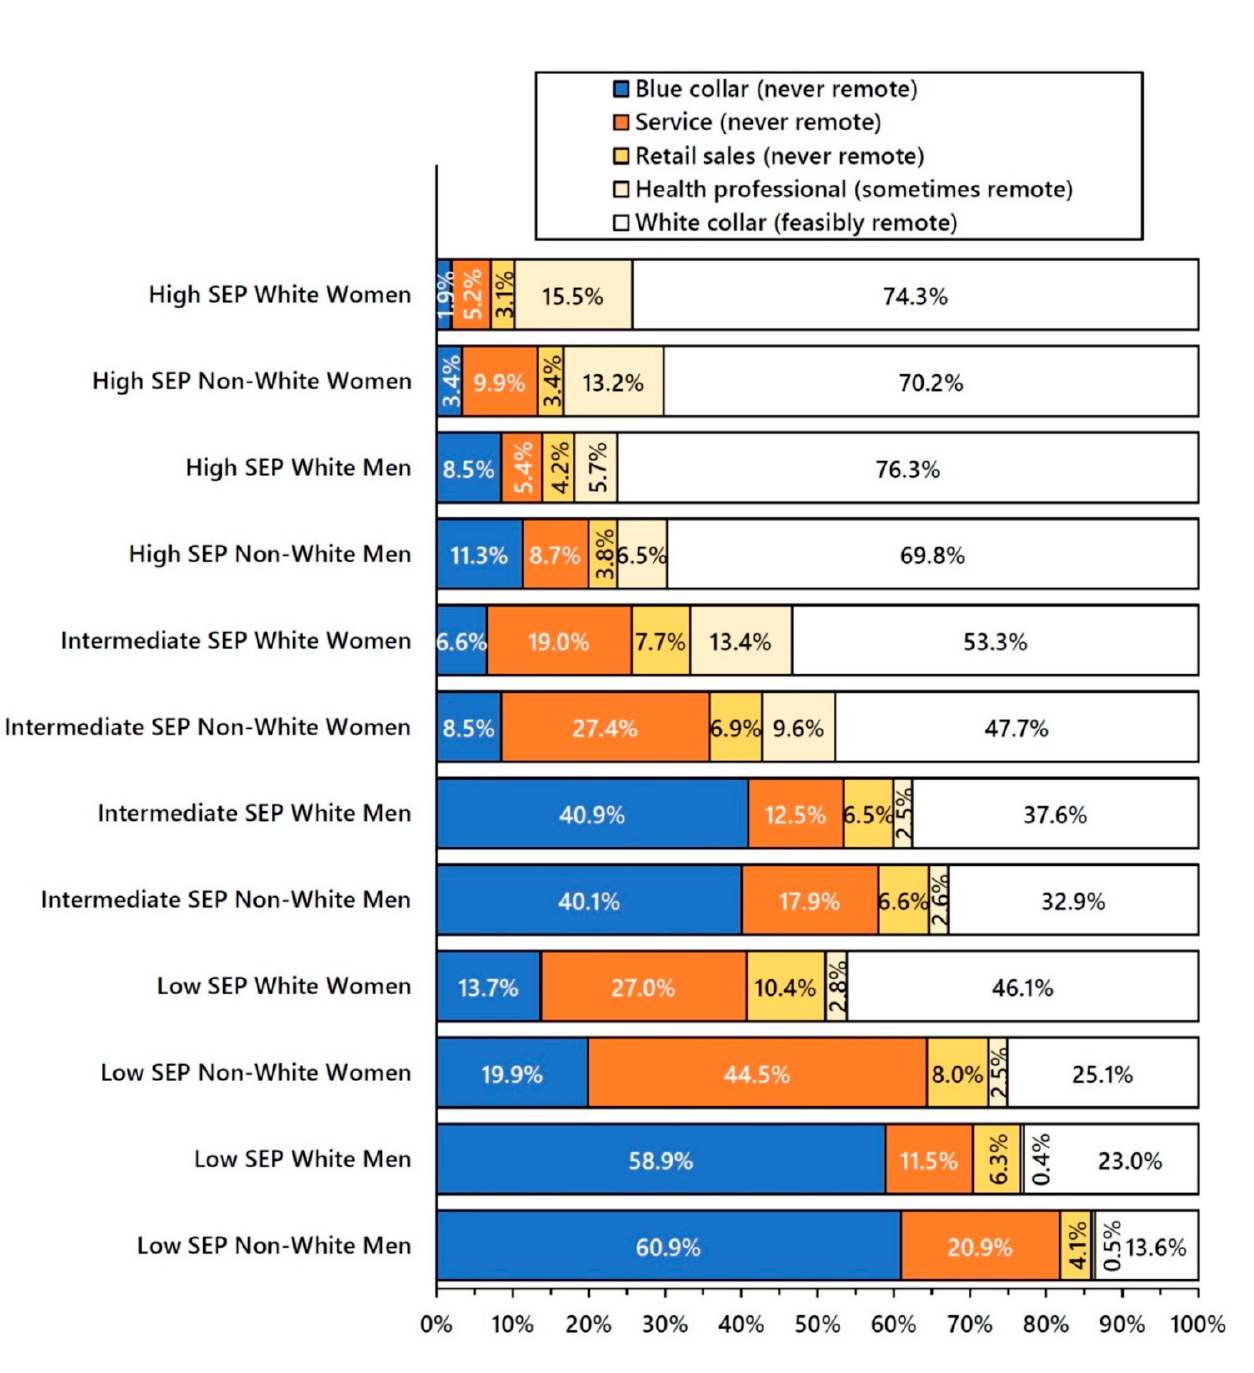
Figure 4. Remote Work Occupations * by Socioeconomic Position (SEP), Gender, and Race/Ethnicity # among Adults 25–64 Years Old, United States 2020. Note : * The denominators for occupation percentages include only persons who were in the labor force with a reported occupation in the Current Population Survey (CPS), the representative sample from which national population estimates were derived. Service occupations include health care support, protective service, food service, housekeeping, building and grounds, and personal care service workers. Registered nurses and licensed practical nurses are classified as health professionals. Transportation workers, including airline pilots and flight attendants, are classified as blue collar. White collar feasibly remote is comprised of managers, professionals, technical workers, non ‐ retail sales workers, and office support and administrative workers. # Non ‐ white includes Hispanic, Black, Asian, Indigenous, and multiracial adults. A population ‐ weighted regression of the natural log ‐ transformed age ‐ adjusted 2020 COVID ‐ 19 death rates revealed a good fit of an exponential model in which the percent of